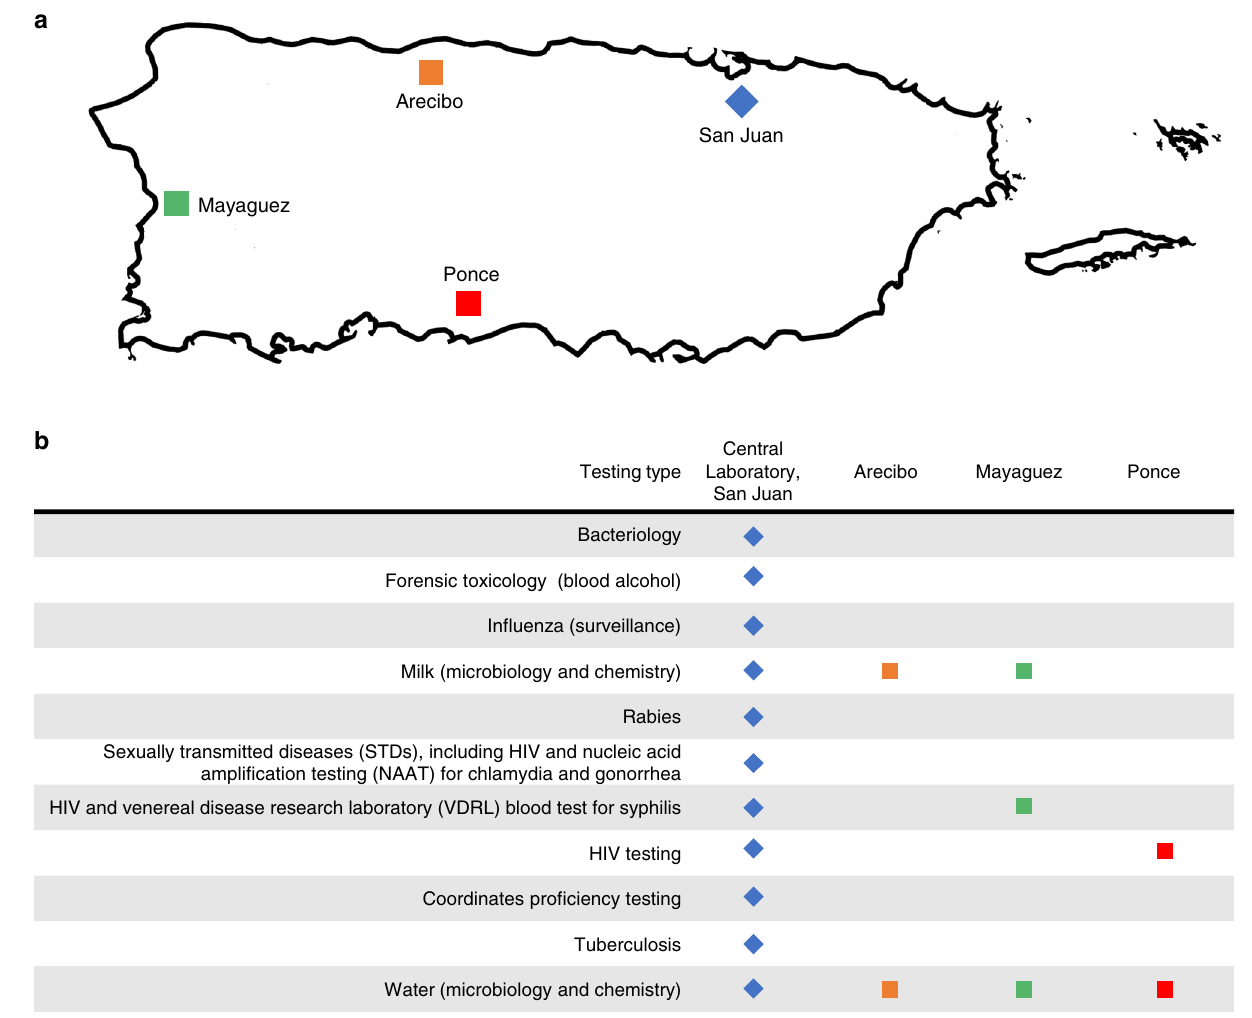
Fig. 1 Description of the Public Health Laboratories in Puerto Rico. The locations ( a ) and the types of testing provided ( b ) are presented. This fi gure is derived from a map originally released into the public domain and available in the Wikimedia Commons repository